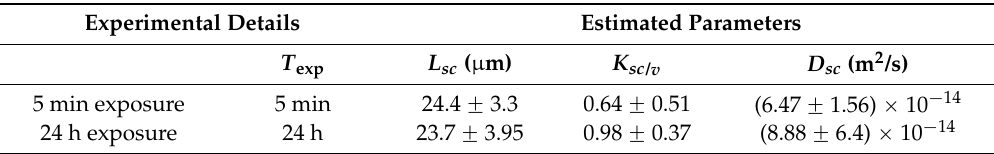
Table 3. Details of TS experiment and parameter